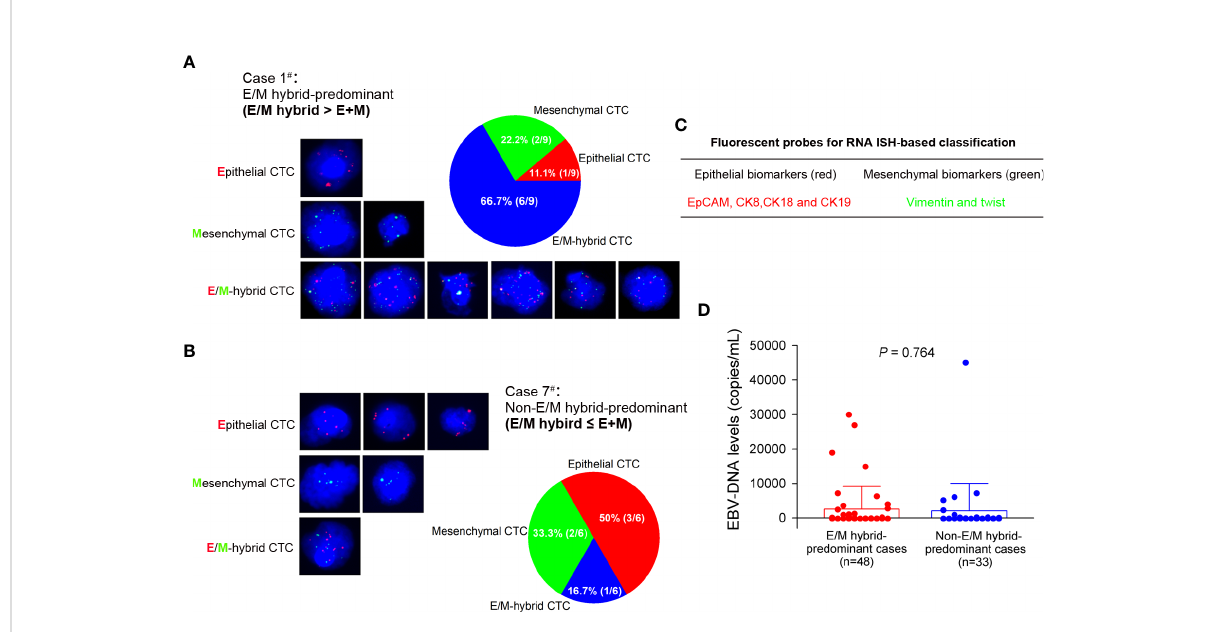
FIGURE 2 RNA in situ hybridization-based phenotypic classi fi cation of circulating tumor cells (CTCs) and plasma Epstein – Barr virus (EBV) DNA level in each group. (A) A representative phenotypic classi fi cation of CTCs from a patient (case 1 # ) with nasopharyngeal carcinoma is shown. Cells stained with epithelial (red fl uorescent probe) and mesenchymal (green fl uorescent probe) markers were classi fi ed as epithelial and mesenchymal CTCs, respectively. Cells stained with both red and green fl uorescent probes were classi fi ed as epithelial/mesenchymal (E/M) hybrid CTCs. Nine CTCs were detected in case 1, of which 66.7% (6/9) were E/M hybrid CTCs. The patient was assigned to the E/M hybrid- predominant group for follow-up. (B) Six CTCs were detected in another patient (case 7 # ), of which 16.7% (1/6) were E/M hybrid CTCs. The patient was assigned to the non-E/M hybrid-predominant group. The cells were analyzed under a fl uorescence microscope with a 100× oil objective. (C) The various epithelial and mesenchymal makers are indicated with red and green fl uorescent probes, respectively. (D) Comparison of the plasma EBV DNA level between the E/M hybrid-predominant and non-E/M hybrid-predominant